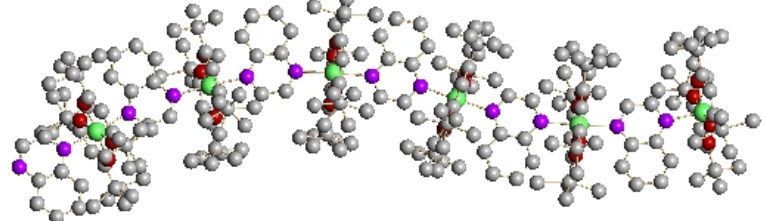
Figure 7. Ball-and-stick model showing a portion of the wavelike polymer chain of trans -[Ni(tmhd) (qox)] ( 4 ). The hydrogen atoms are not included for clarity (C, gray; 2 n Ni, green; N, purple; O, red).